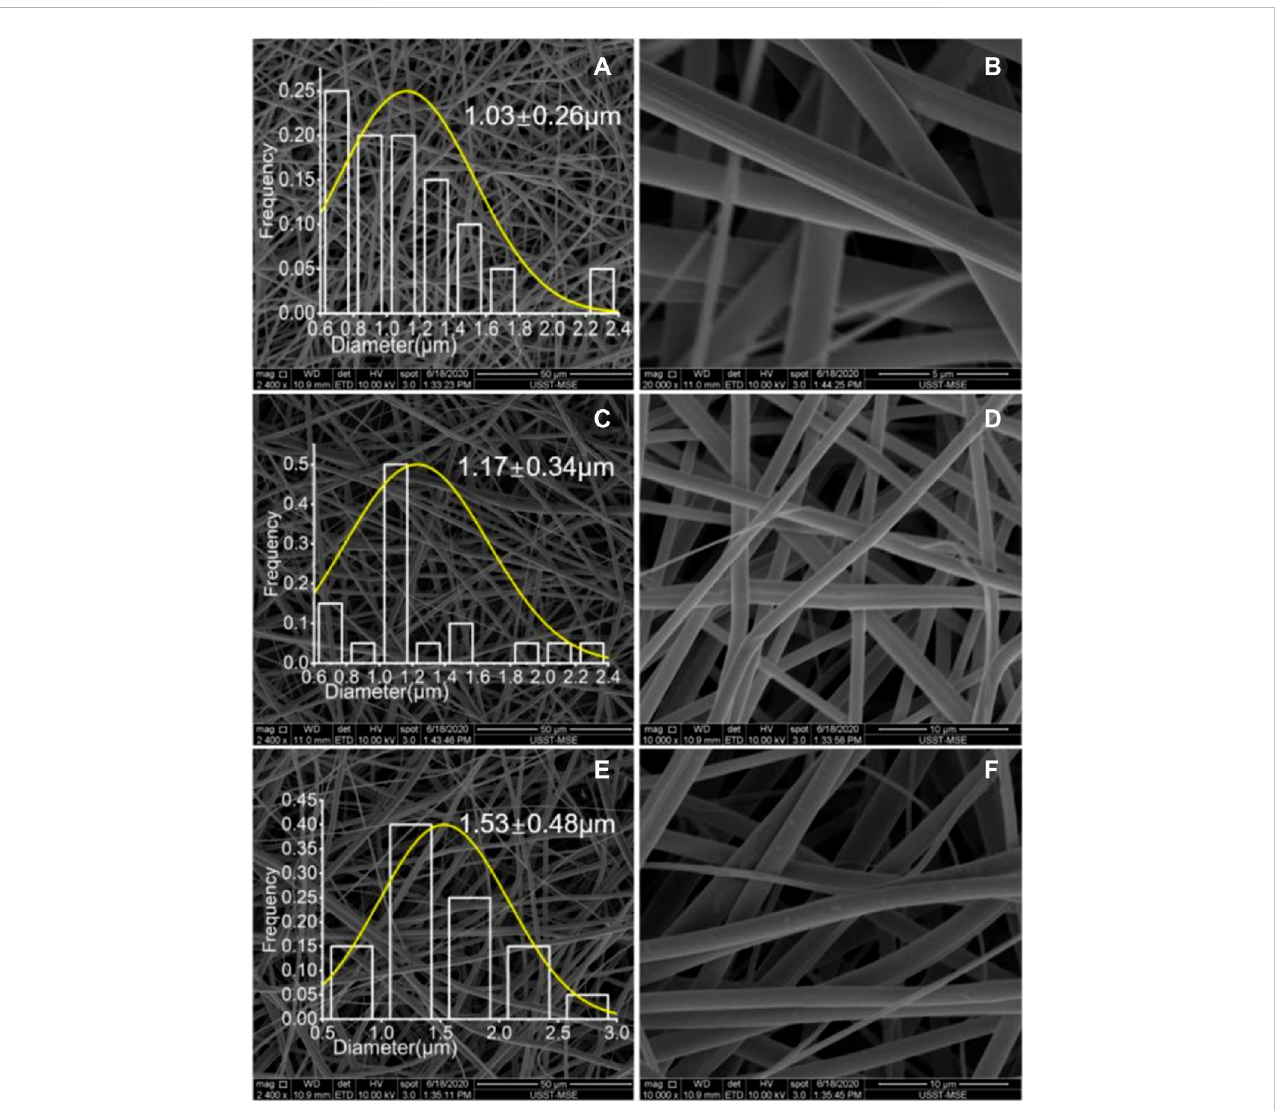
FIGURE 4 SEM images of the electrospun nano fi bers under different magni fi cations: (A) and (B) S1; (C) and (D) S2; (E) and (F) S3.